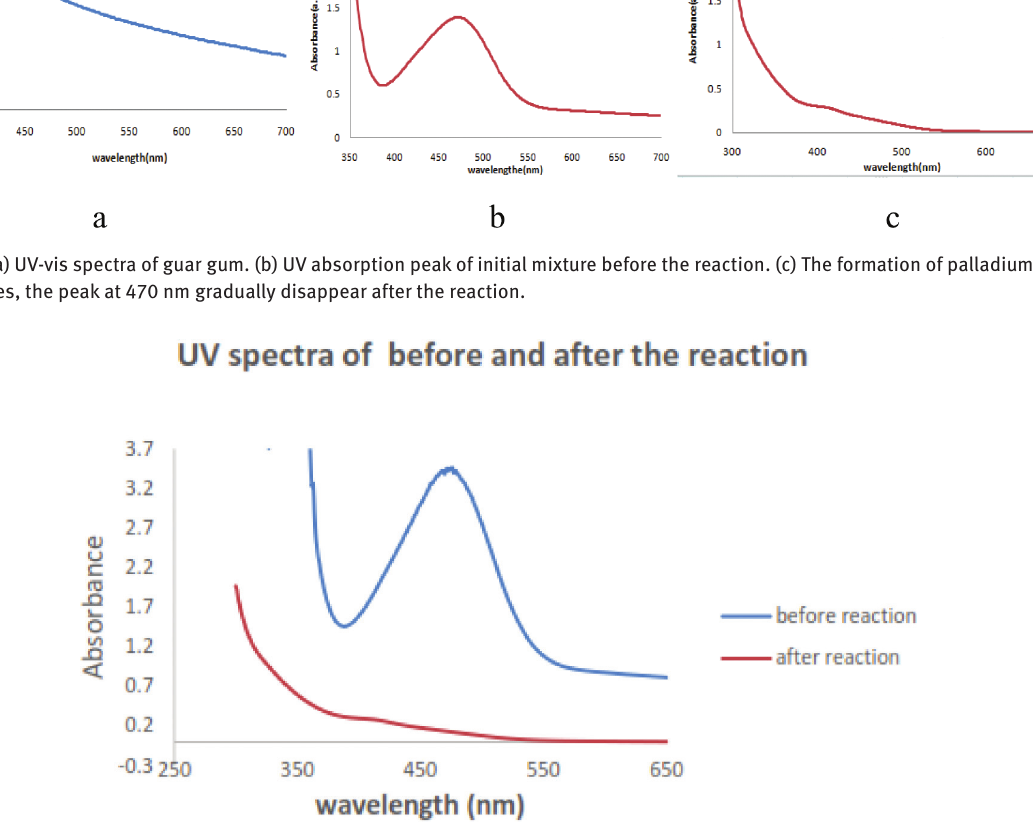
Figure 4: UV spectra before and after reaction, showing the formation of palladium